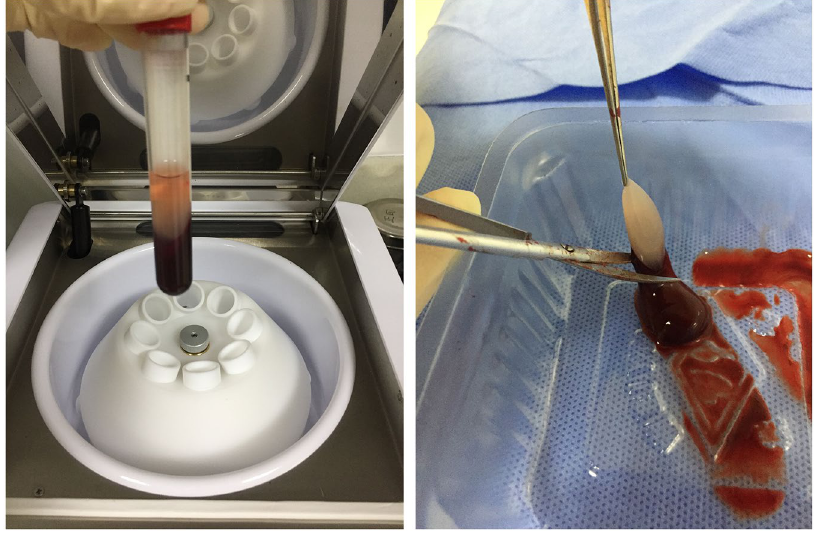
Figure 1. CGF was prepared from rat blood without anticoagulants by centrifuging in a special centrifuge device, then used for the in vivo